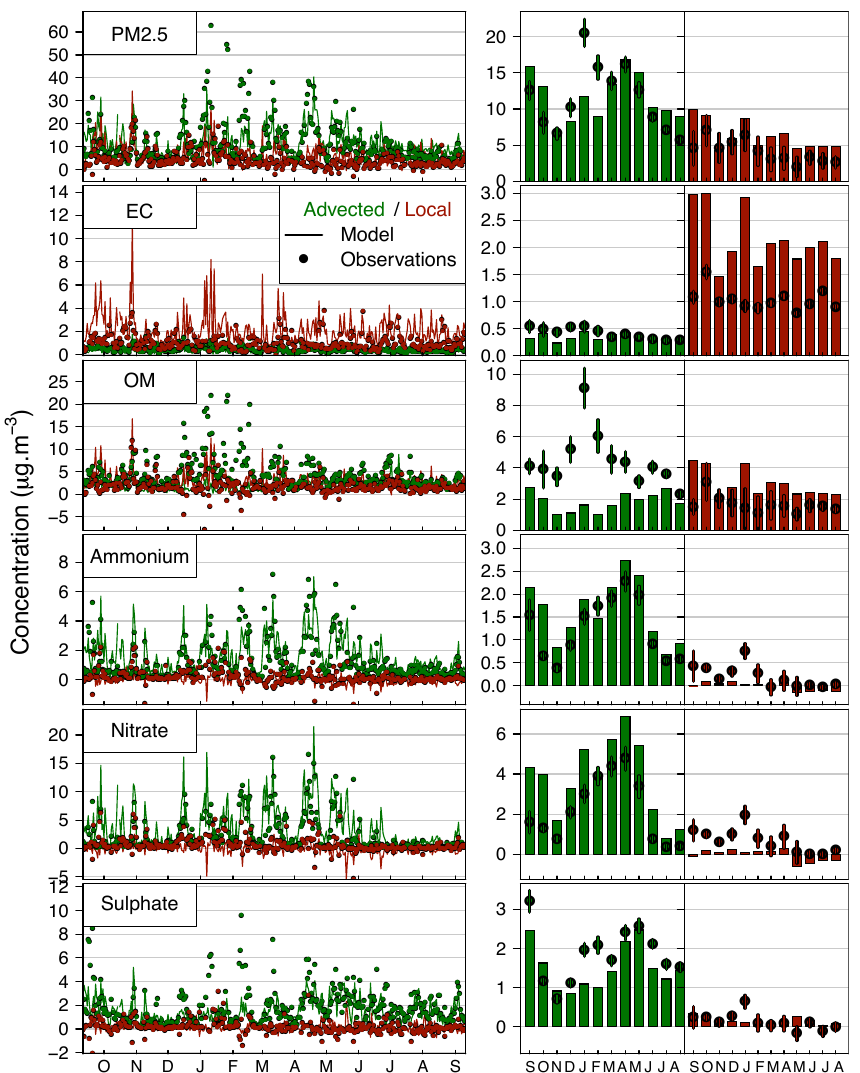
Figure 9. Daily time series (left panel) and monthly variations (right panel) of modeled (lines) and observed (points) advected (green) and local (red)